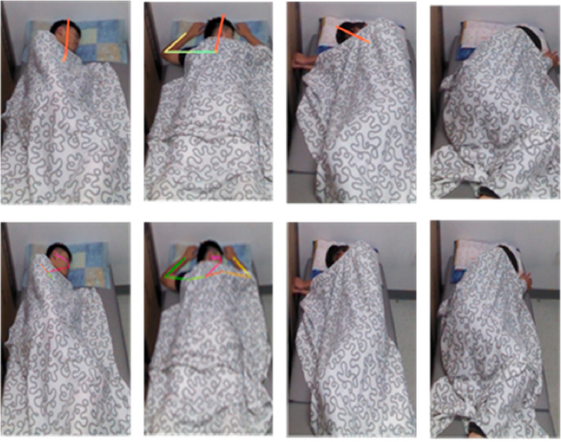
Figure 12. Repurposed SimpleBaseline [49] (first row) and OpenPose [50] (second row) performance on the iSP dataset.